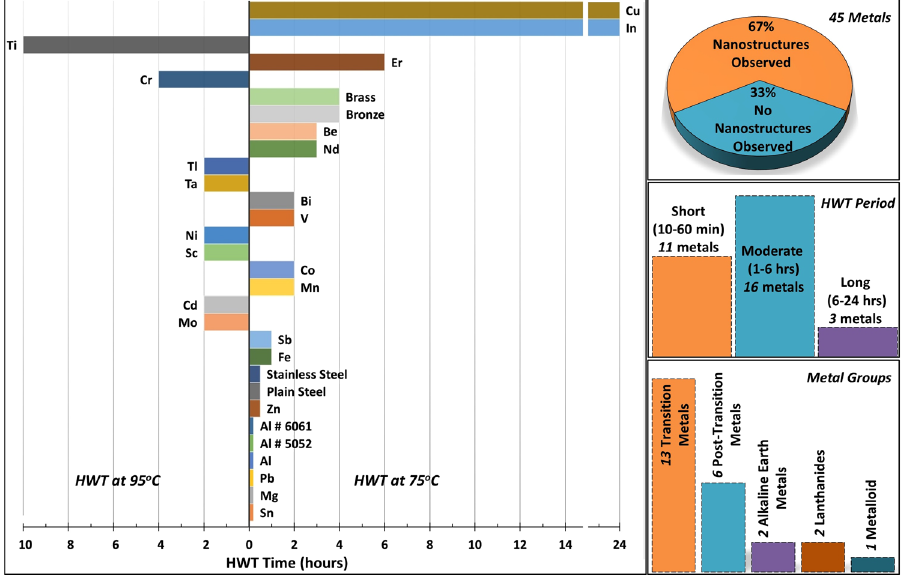
Figure 2. Bar diagram illustrates approximate minimum HWT times required before distinct MONSTRs can be observed on the metals of this study. Most of the metals form nanostructures at 75 °C (pointing to the right in bar diagram) while few others require a higher temperature of 95 °C (left). On the right column, some statistical data about the response of metals to HWT with respect to metal group (top histogram graph), required treatment periods for nanostructure formation (middle), and percentage of metals that did or did not respond to HWT